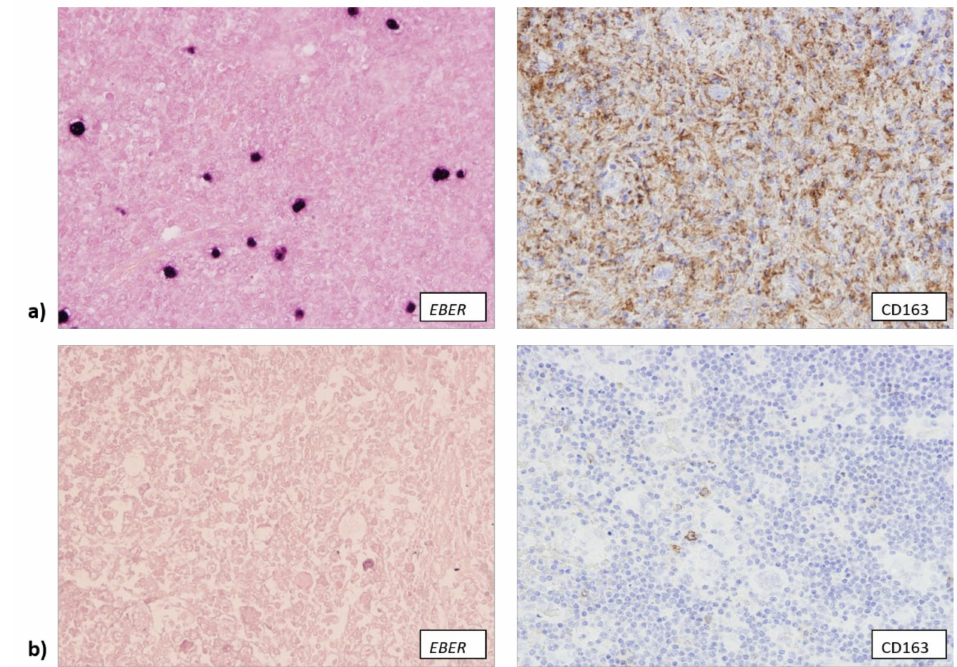
Figure 2. ( a ) Tissue samples in which EBER (Epstein-Barr encoding RNA) mRNA was detected (400 × total magnification) contained a larger number of CD163+ cells (400 × total magnification). ( b ) EBV-negative samples (400 × total magnification) contained a lower number of CD163+ cells (400 × total